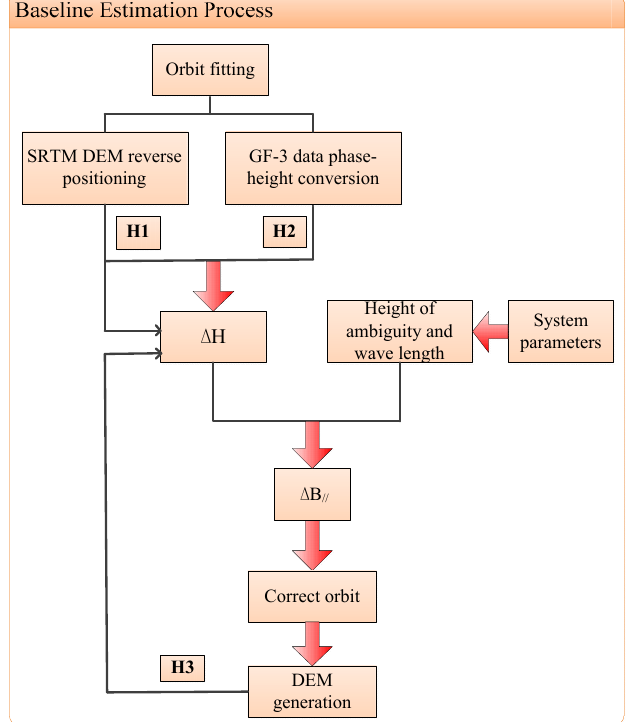
Figure 4. Baseline estimation with Shuttle Radar Topography Mission Digital Elevation Model (SRTM DEM).